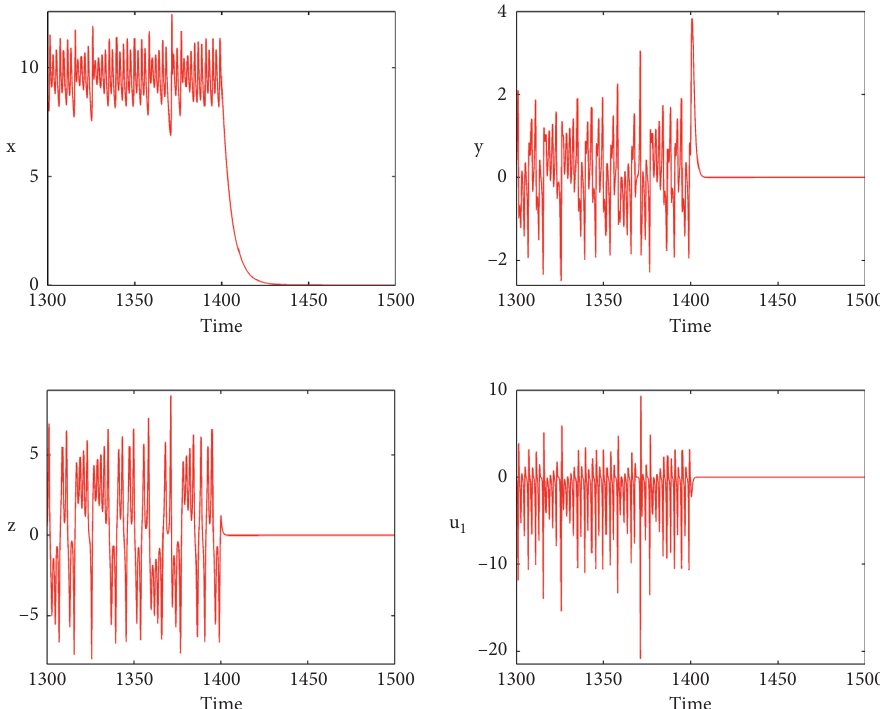
Figure 4: Time series of x, y, z , u for a � 3, b � 0 . 2, and c � 22. The initial conditions are (x(0), y(0), z(0)) � (0.1, 0.2, 1